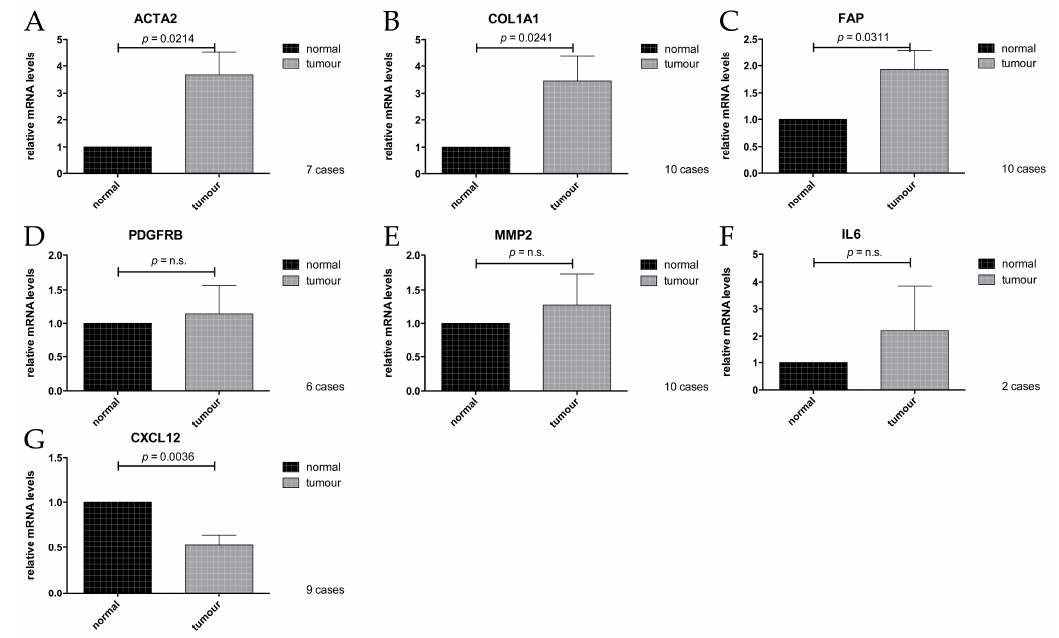
Figure 3. Relative mRNA levels of CAS-associated genes in normal stroma and tumour stroma isolated by laser-capture microdissection (LCM), measured by RT-qPCR. ( A ): ACTA2; ( B ): COL1A1; ( C ): FAP; ( D ): PDGFRB; ( E ): MMP2; ( F ): IL6; ( G ): CXCL12. Values are mean values ± SEM, normalised to expression levels in normal stroma. p -values were calculated using student’s t -test, and significance was set at p ≤ 0.05. n.s. = not significant.